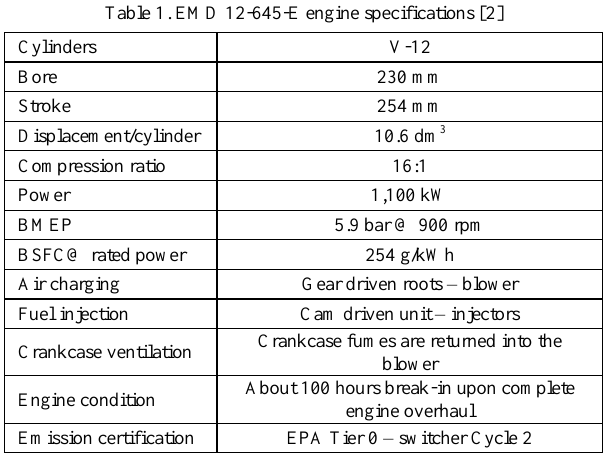
Table 1. EMD 12-645-E engine specifications